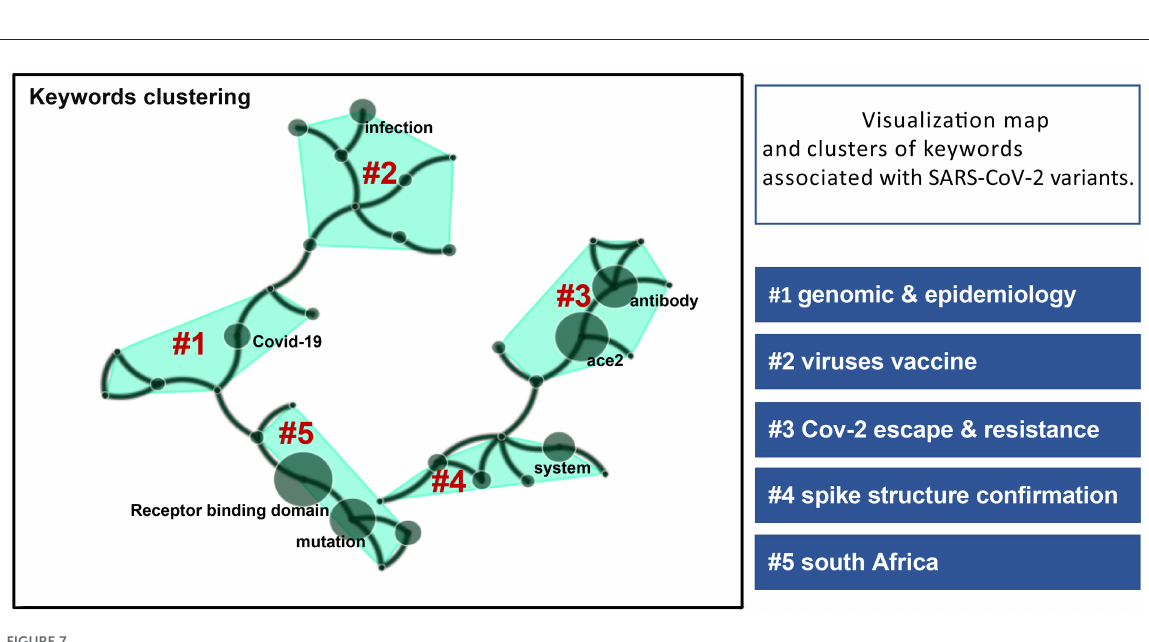
Two hundred and thirty keywords were extracted from the 100 cited articles and were classified into five